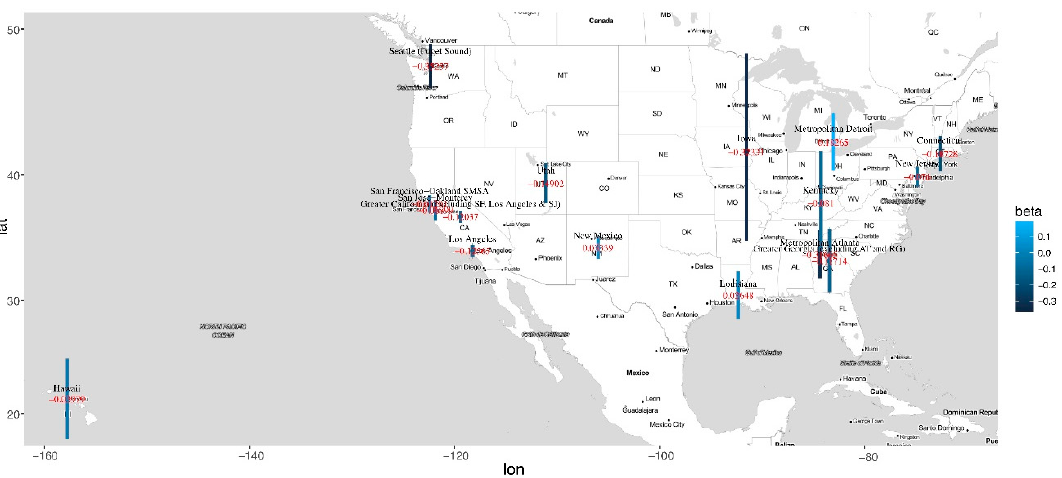
Figure 4. Analysis results for each location and by pooling data from all time intervals: estimated coefficient and 95% confidence interval (vertical bar) for race (White).